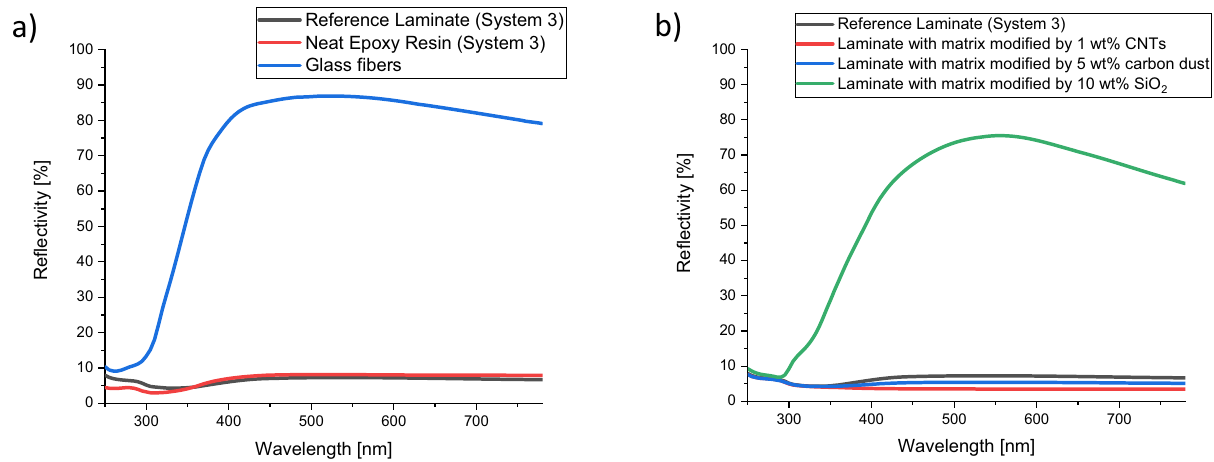
Figure 5: ( a ) Re fl ectivity of unmodi fi ed reference samples. ( b ) Re fl ectivity of glass fi ber laminates with three di ff erent matrix modi fi cations ( system 3 )